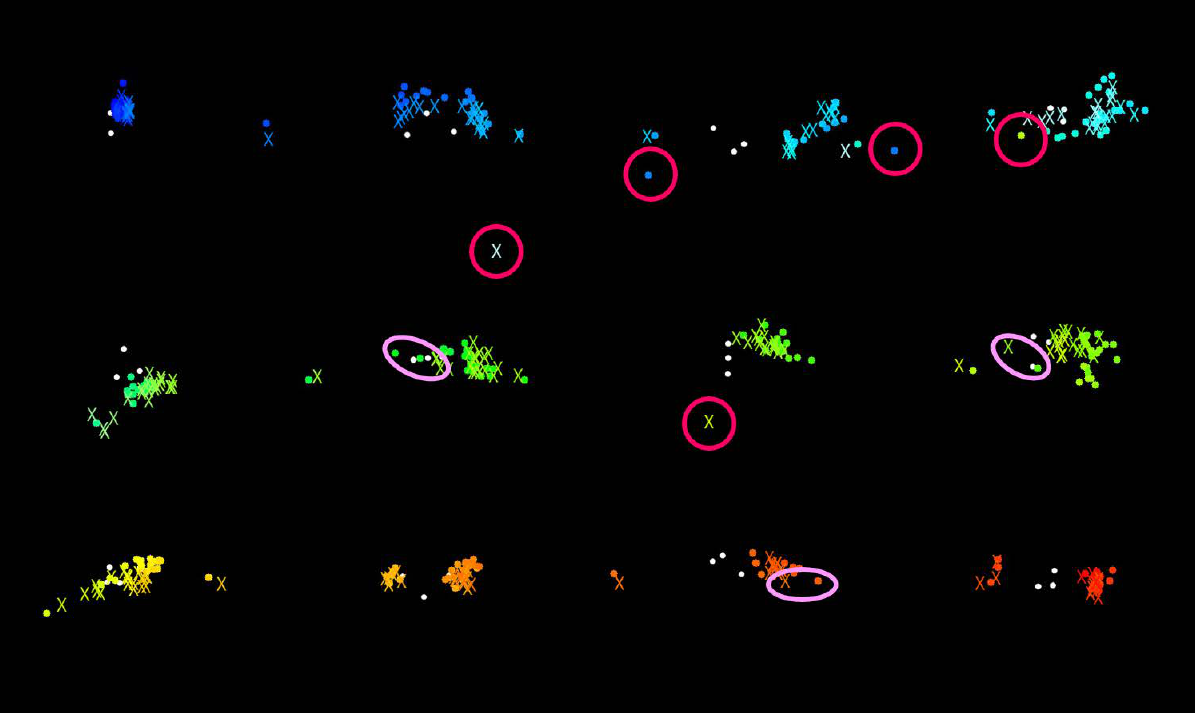
Figure 14: Points containing the errors of template matching (light pink: relatively large gap, dark pink: no